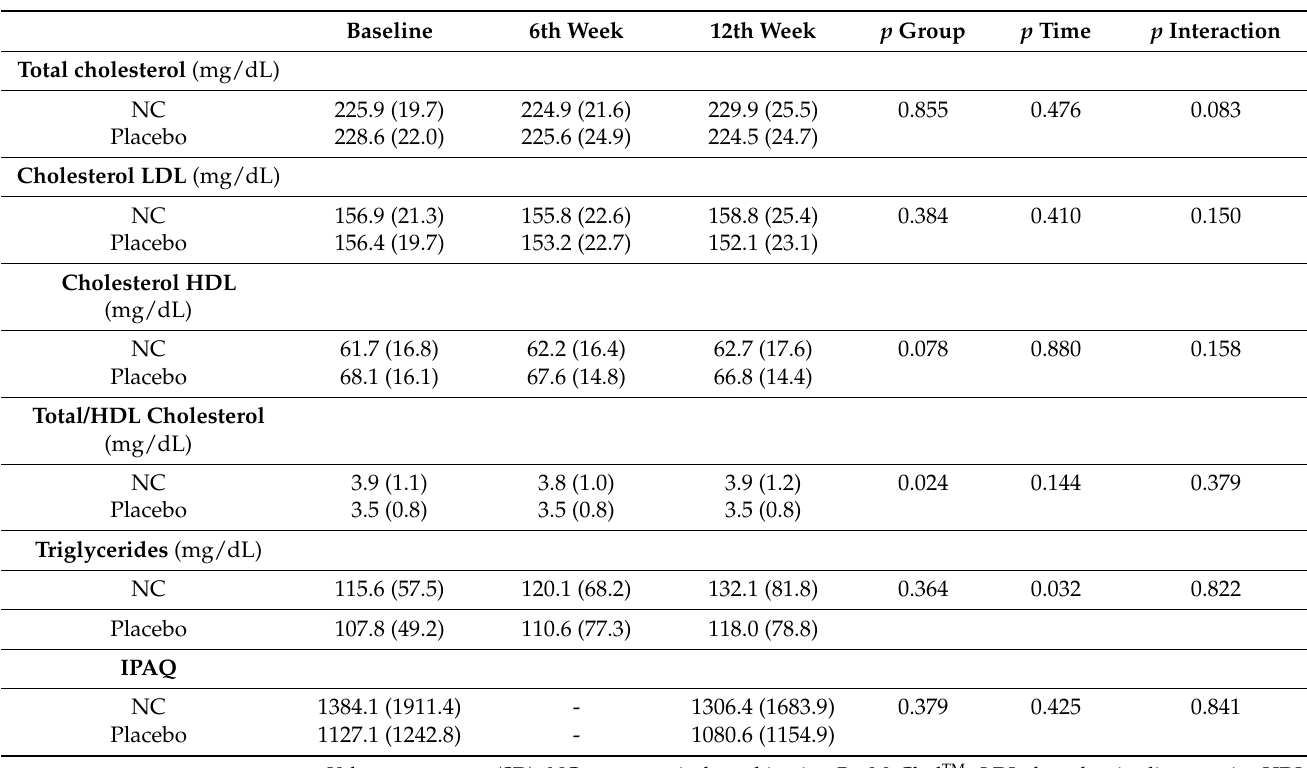
Table 3. Baseline and 6- and 12-week’s levels in lipid profile and IPAQ values by group allocation.